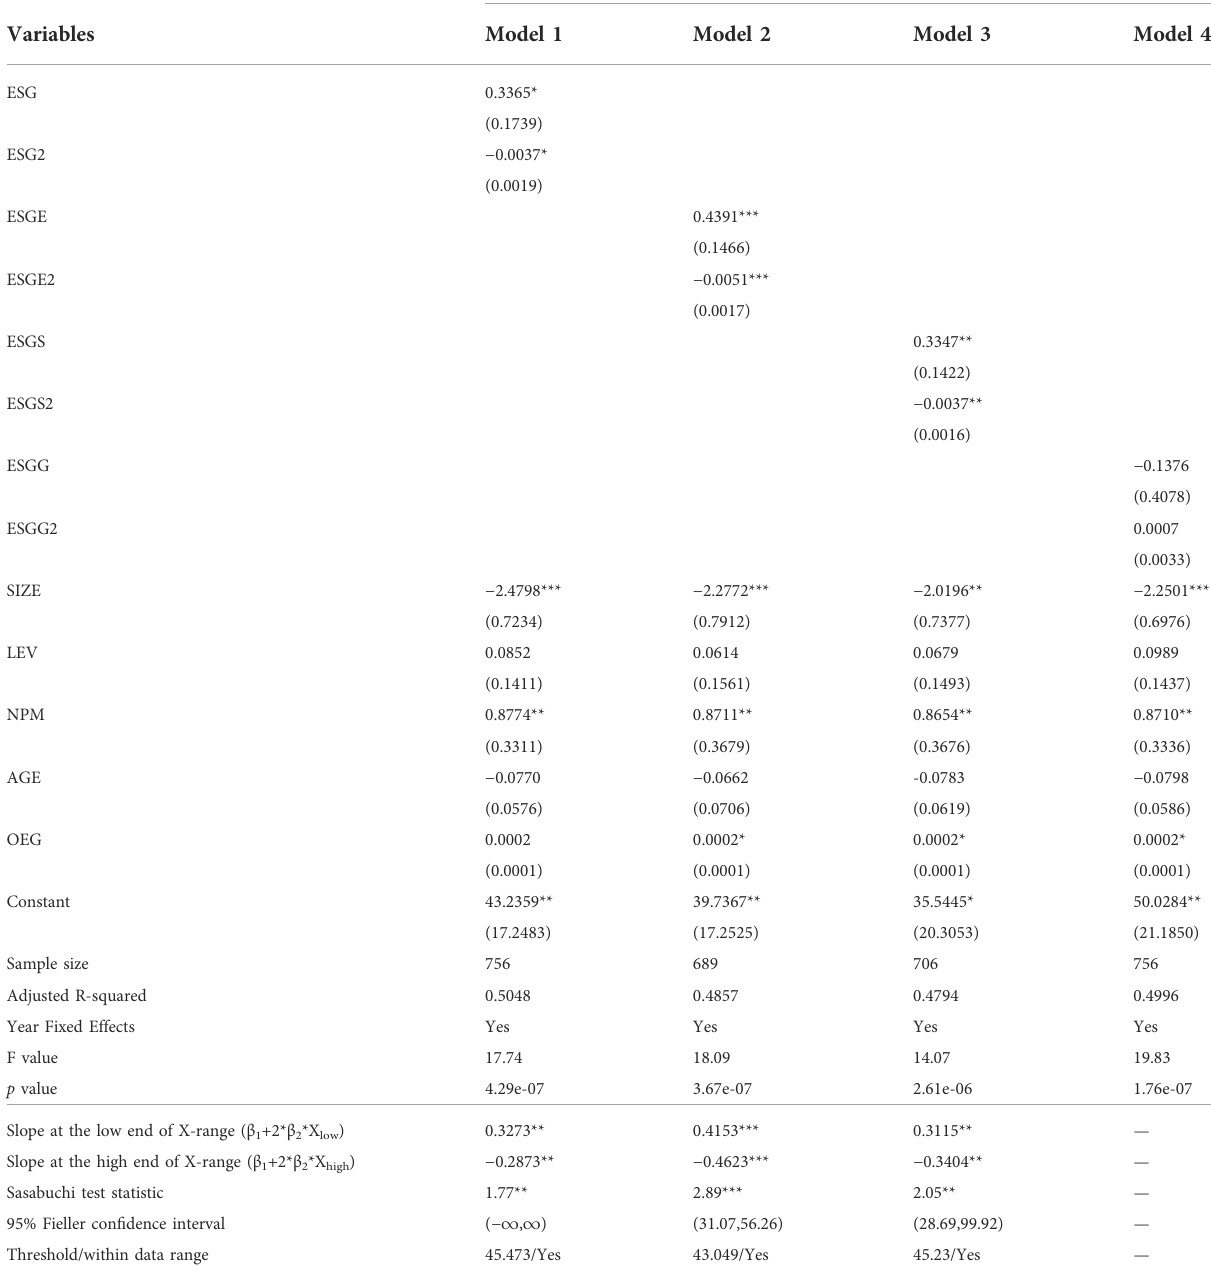
TABLE 2 Baseline nonlinear model using